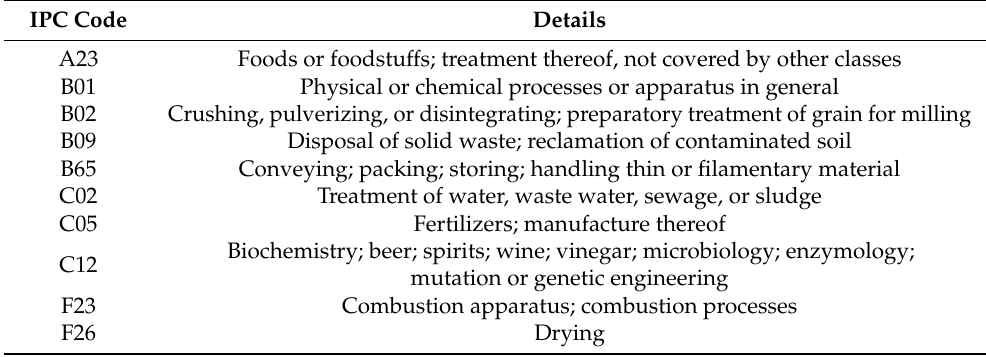
Table 8. Details of the top-ten IPC code groups in patent analysis.